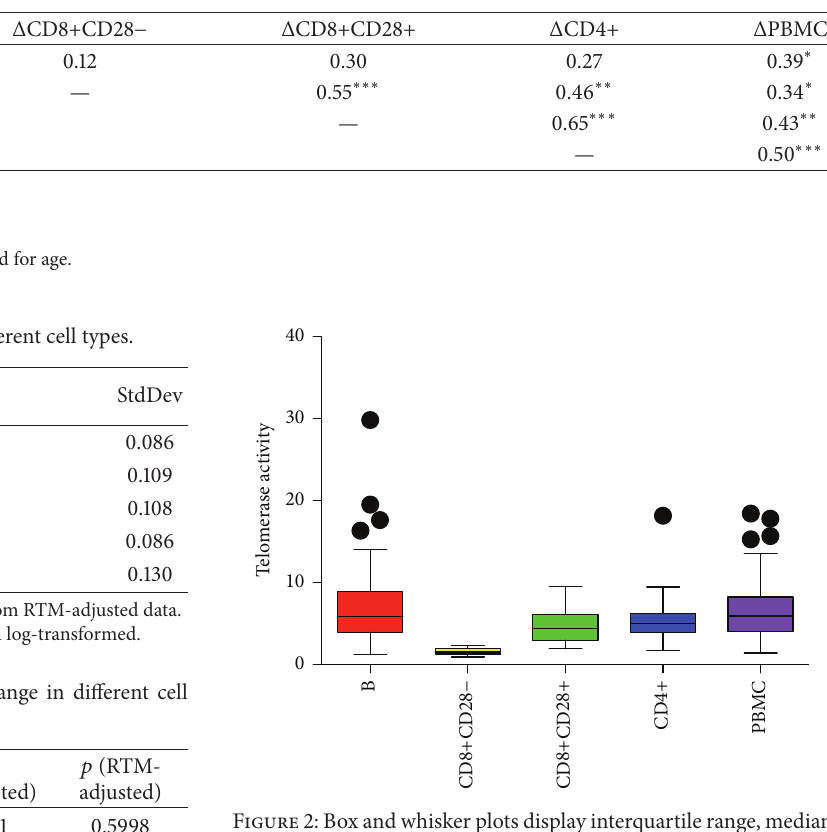
Figure 2: Box and whisker plots display interquartile range, median values, and maximum and minimum values of telomerase activity